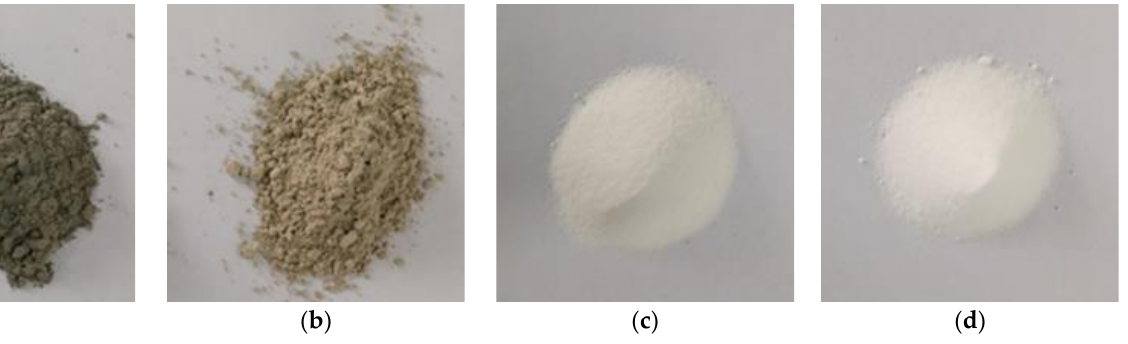
Figure 1. Cement and admixture: ( a ) cement, ( b ) accelerating agent, ( c ) water-reducing agent, and ( d ) expansion agent.